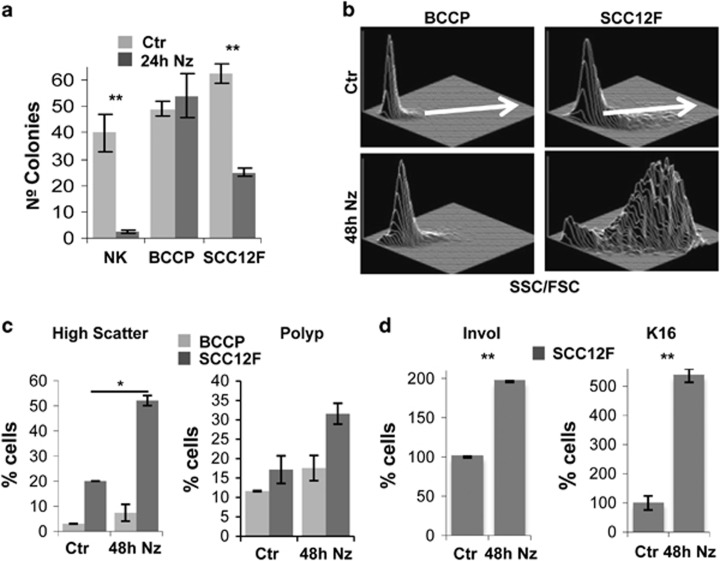
A Nocodazole treatment induces a partial anti-proliferative squamous differentiation response in SCC12F cells but not in BCCP cells. (a) Clonogenic capacity of normal keratinocytes (NK), BCCP and SCC12F untreated (DMSO only, Ctr) or after a 24h Nocodazole (Nz) treatment (Supplementary Figure 5a). (b) Representative 3D histograms of light scattering (SCC: Side Scatter; FSC: Forward Scatter; cell size and complexity; white arrow) in BCCP and SCC12F untreated (Ctr) or treated with Nz for 48 h. (c) Percent of cells with large size and complexity (High Scatter) or polyploidy (Polyp, DNA content >4N), as measured by flow-cytometry in BCCP (light grey) or SCC12F (dark grey) treated with Nz for 48 h or untreated (Ctr) as indicated. See also Supplementary Figures 5b–d. (d) Percent of SCC12F cells treated with Nz for 48 h that express the differentiation markers involucrin (Invol) or keratin K16, relative to untreated cells, as measured by flow-cytometry. Error bars are s.e.m. of duplicate or triplicate samples of at least two independent representative experiments.*P<0.05 and **P<0.01. See also Supplementary Figure 6